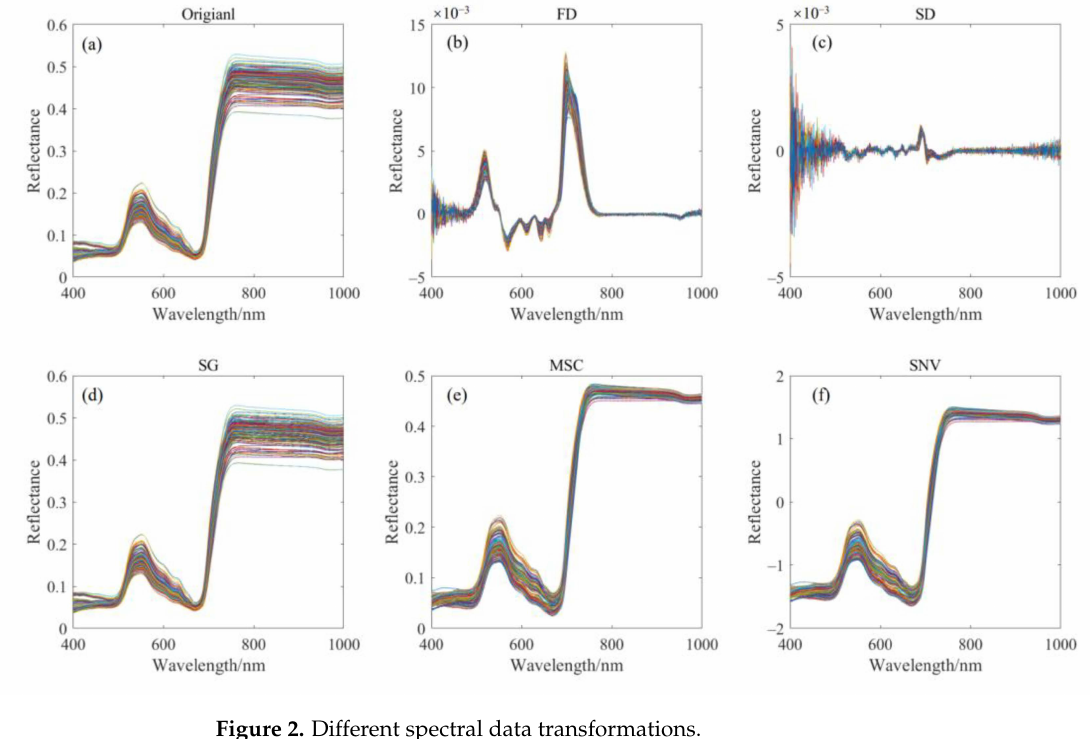
Figure 2. Different spectral data transformations.